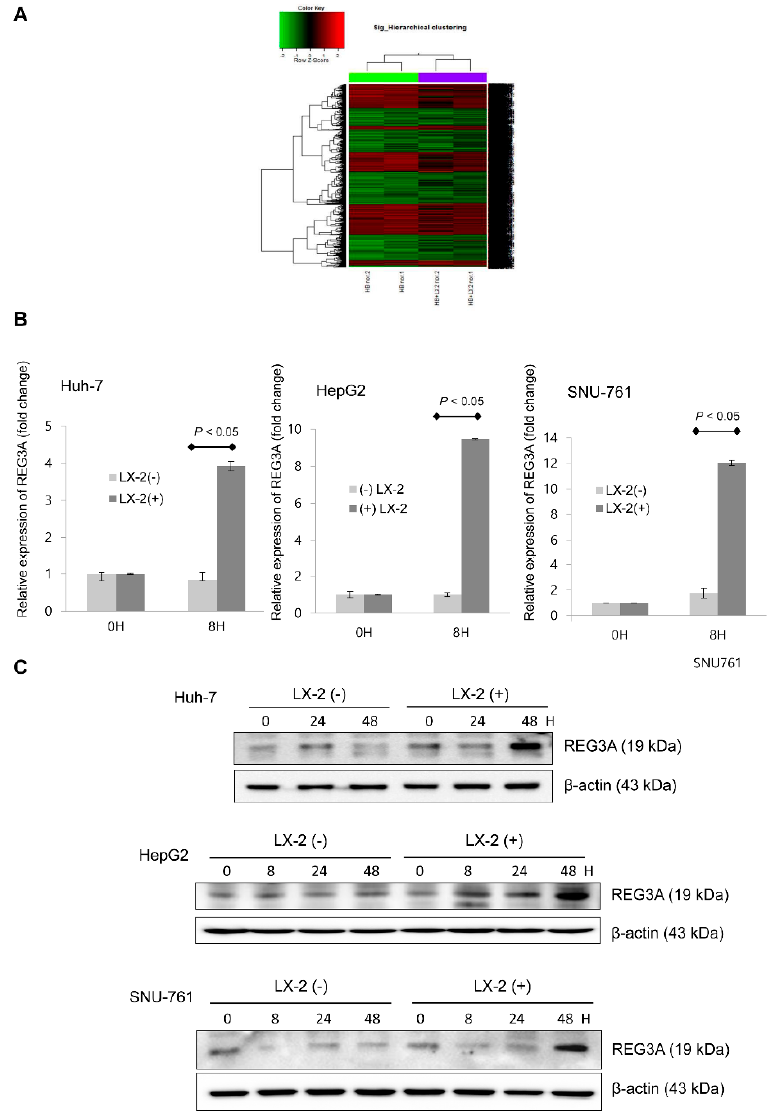
Figure 1. Coculture of hepatocellular carcinoma (HCC) cells and hepatic stellate cells (HSCs) enhanced the expression of regenerating gene protein-3A (REG3A). ( A ) Complementary DNA (cDNA) microarray results (volume plot of expression level, hierarchical clustering analysis). ( B ) REG3A mRNA in HCC cells was significantly enhanced when coculturing with HSCs compared with monoculturing. REG3A mRNA was quantified using real-time polymerase chain reaction (qPCR) and normalized to glyceraldehyde-3-phosphate dehydrogenase (GAPDH) expression levels. The experiment was repeated three times. The data are expressed as mean ± SD. ( C ) The protein expression of REG3A in HCC cells was significantly enhanced when coculturing with HSCs compared with monoculturing, especially at 48 h. The experiment was repeated three times.